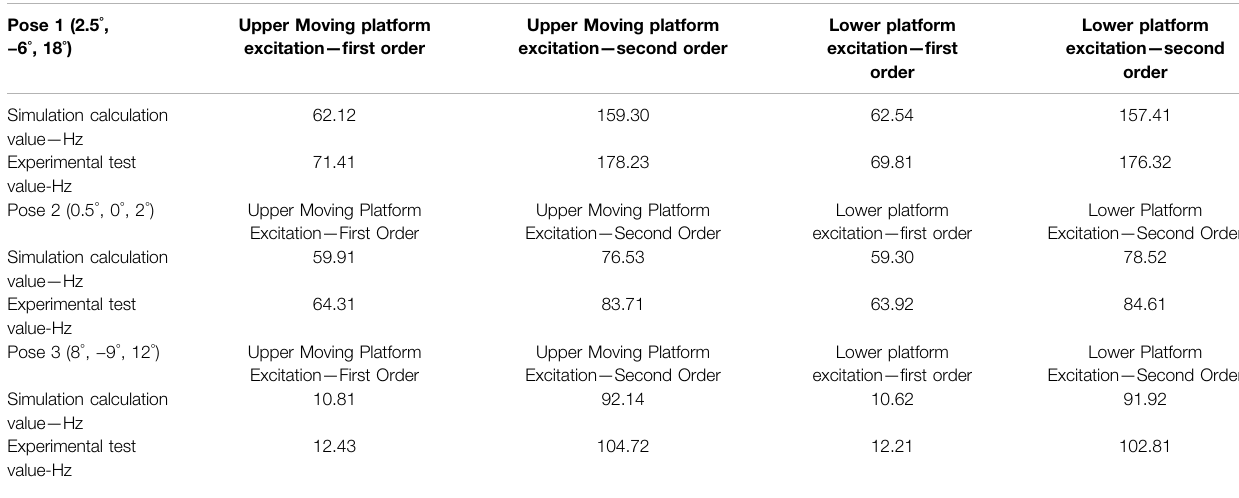
TABLE 3 | Typical pose natural